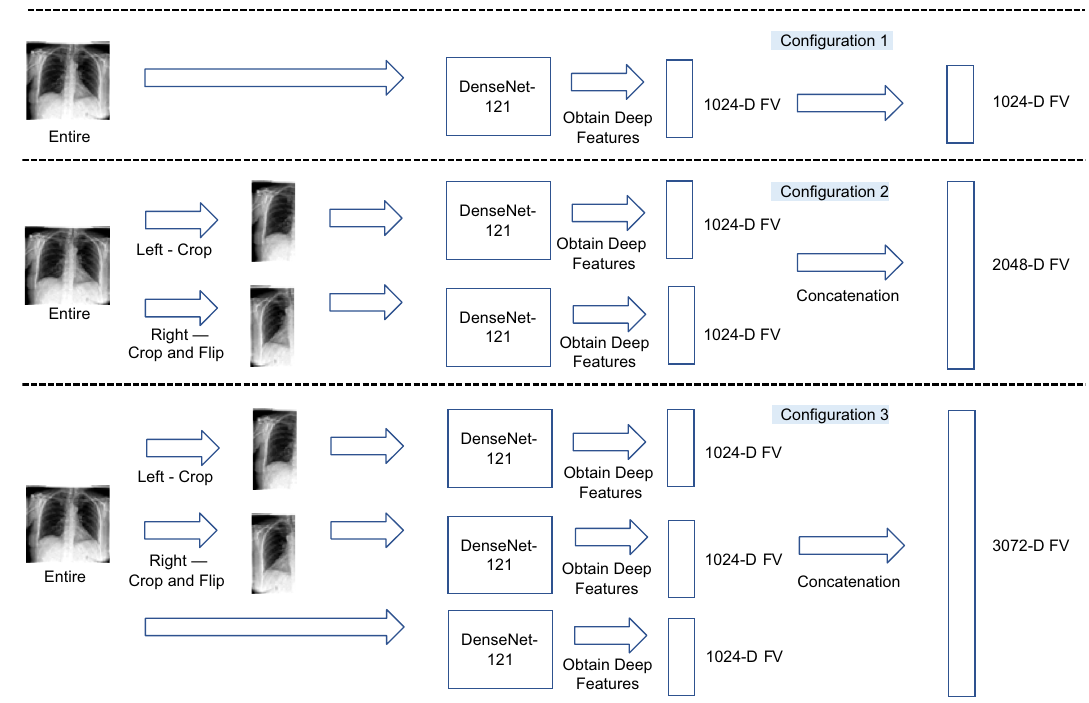
Figure 3. An overview of the three configurations using DenseNet121 26 to extract features from a chest X-ray images. Configuration 1: a feature vector is extracted from the entire chest X-ray image. Configuration 2: two feature vectors are extract from the left chest side and flipped right chest side. The final feature vector is a concatenation of these two feature vectors. Configuration 3: three feature vectors are extract from the left chest side, the flipped right chest side, and the entire chest X-ray image,